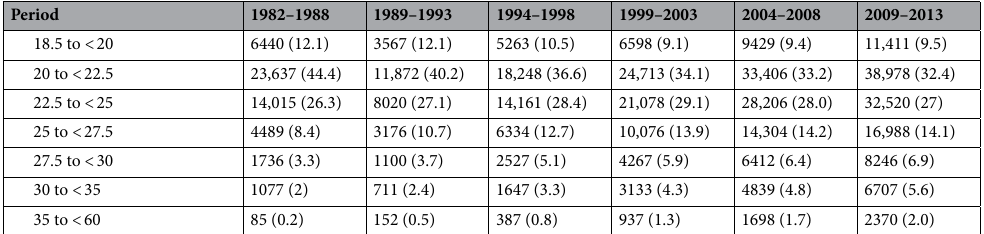
Table 1. Characteristics, age-adjusted mean BMI, and prevalence of BMI in eight categories by period and education. n number of individuals, BMI body mass index, SD standard deviation. a Missing data for